Question: Give a one-sentence summary of this figure.
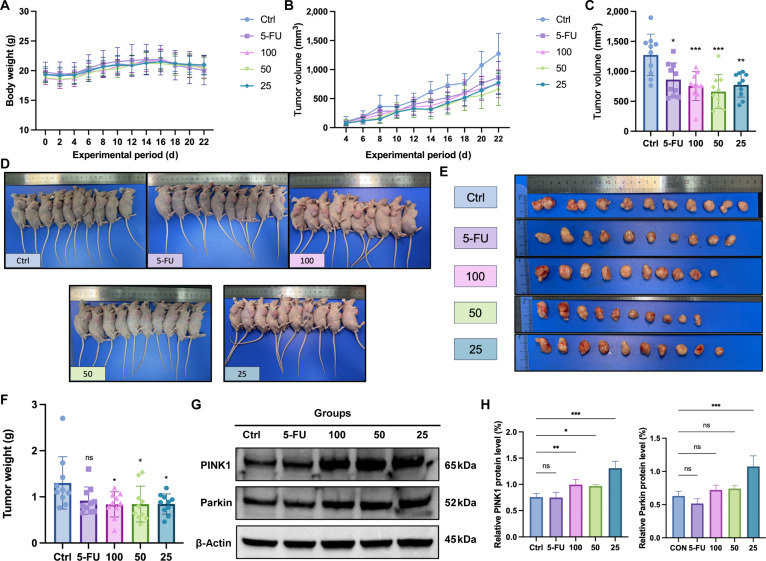
Answer: Metochalcone (MET) suppresses tumor growth in HCT-116 xenograft mice. (A) Body weight changes of BALB/c-nu mice treated with different doses of MET or 5-fluorouracil (5-FU). (B to E) Tumor volume measurements and images of mice from each group. (F) Tumor weights at the end of the study. (G and H) Western blot analysis of PINK1 and Parkin protein expression in excised tumor tissues from different treatment groups.